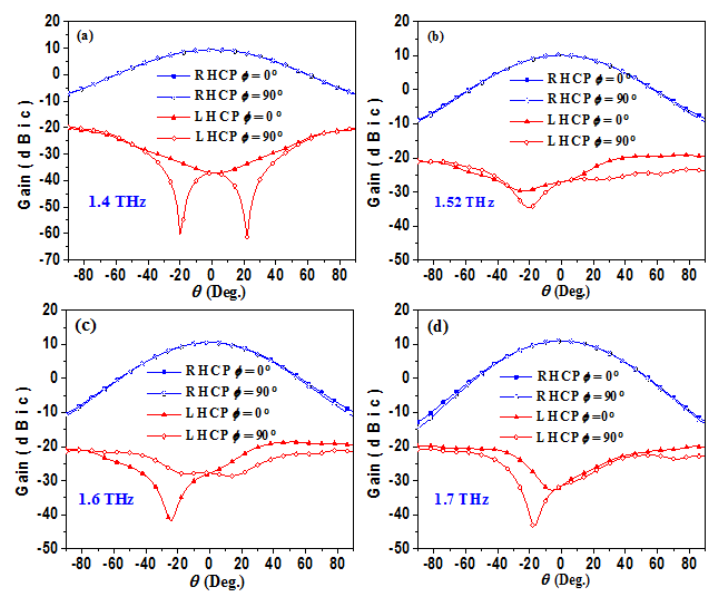
Figure 6. ( a ) Simulated 2-D radiation pattern of the feeding horn antenna at 1.4 THz. ( b ) The simulated 2-D radiation pattern of the feeding horn antenna at 1.52 THz. ( c ) The simulated 2-D radiation pattern of the feeding horn antenna at 1.6 THz. ( d ) The simulated 2-D radiation pattern of the feeding horn antenna at 1.7 THz. In all panels the gain of RHCP and LHCP components in φ = 0° plane and φ = 90° plane are demonstrated, respectively.